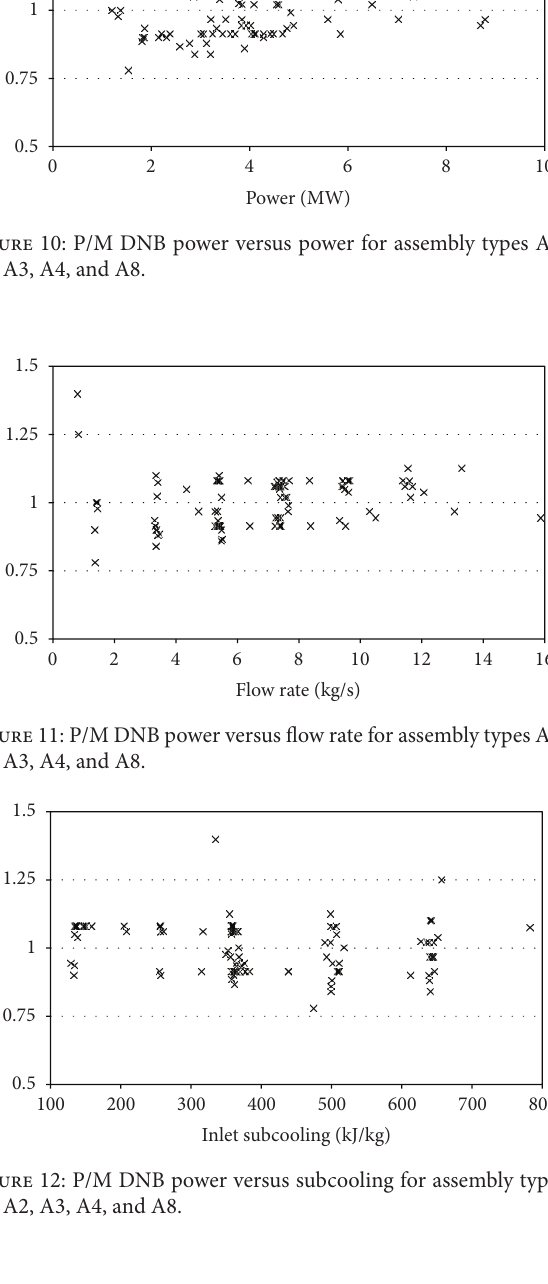
F 12: P/M DNB power versus subcooling for assembly types A0, A2, A3, A4, and A8.